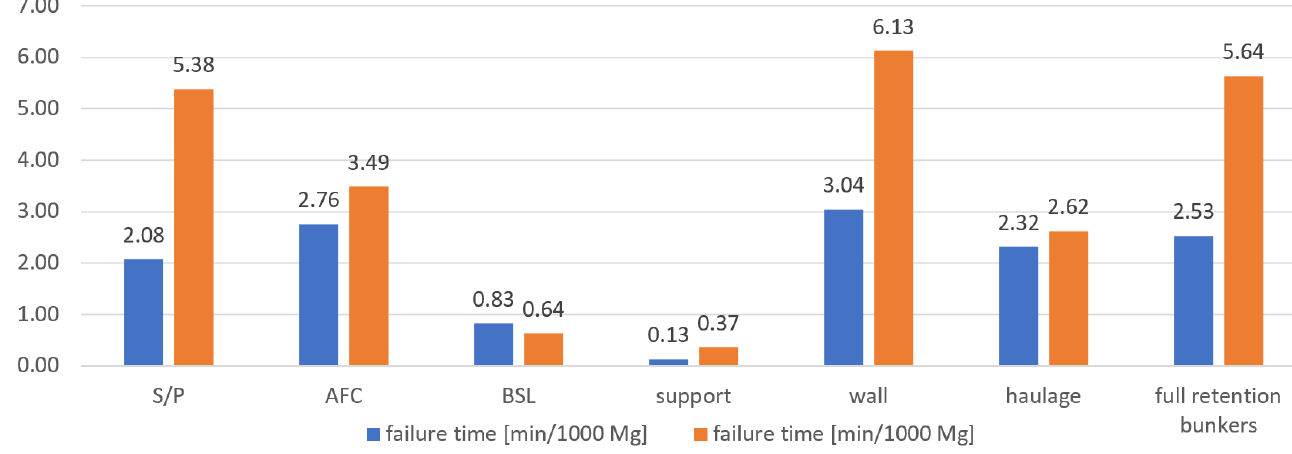
Figure 15. Comparison of the total failure duration per 1000 Mg of excavated material.